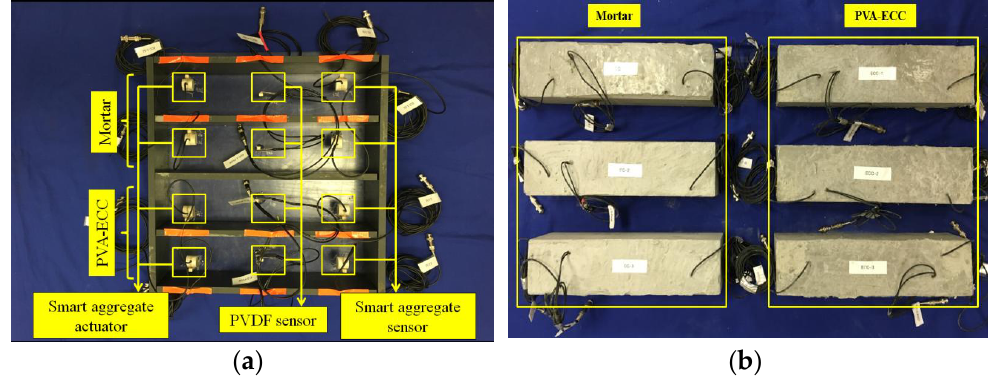
Figure 4 . Specimen preparation. ( a ) molds with pre-installed PVDF sensors and smart aggregates ( b ) casted PVA-ECC and mortar beams.